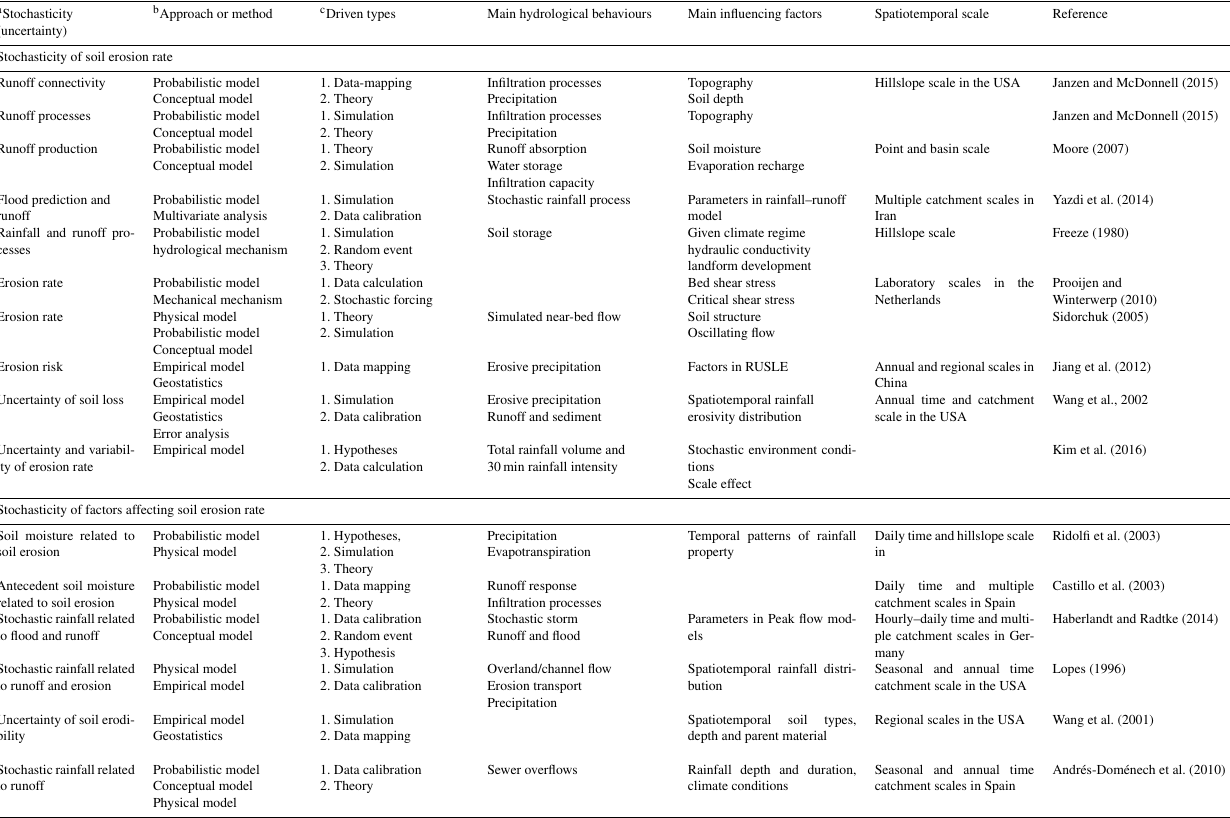
Table 1. Summary of the research on the stochasticity of soil erosion rate and the stochasticity of factors affecting soil erosion rate. a Stochasticity